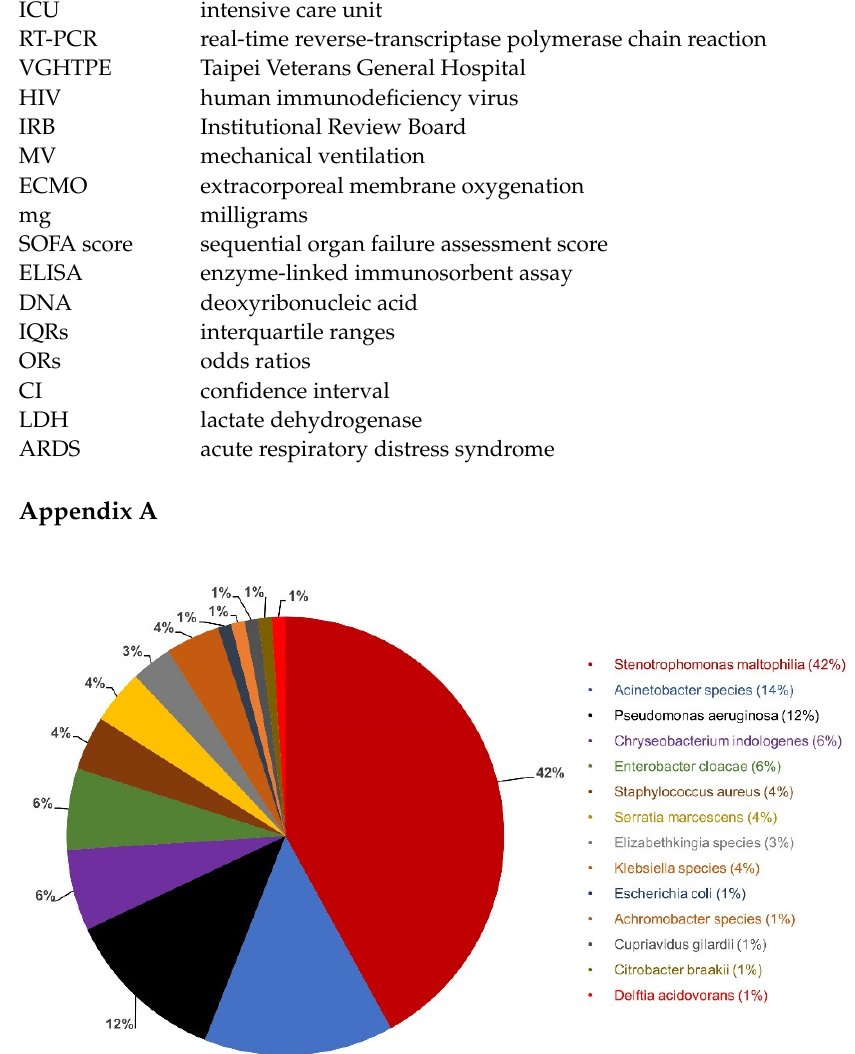
Figure A2. Analysis of the association between viral shedding and different pathogens. SM: Steno- trophomonas maltophilia ; A spp: Acinetobacter species ; PsA: Pseudomonas aeruginosa.